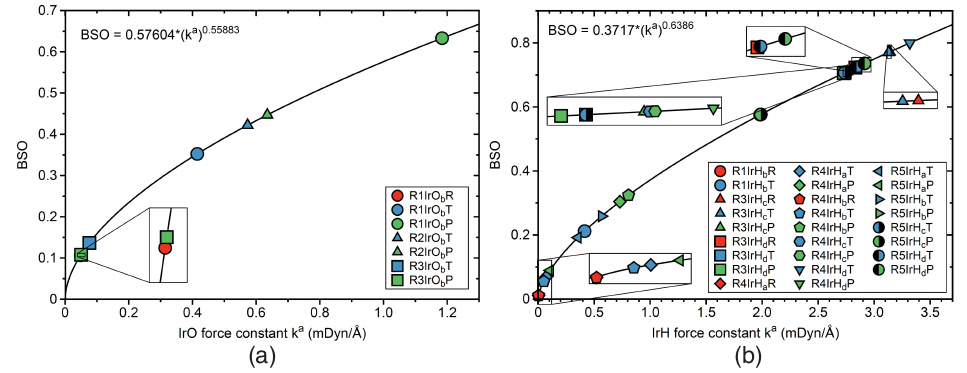
Figure 11. BSO values as a function of the local mode force constants k a , calculated from the power relationship BSO = A ∗ ( k a ) B ; for details, see text and Table 1. ( a ) IrO bonds; ( b ) IrH bonds. Labels R1IrO b R, R1IrO b T, and R1IrO b O indicate reactant RE (red color), TS (blue color), and product PR (green color) of the bond involving the Ir and O b atoms of thereaction R1 . Similarly notation for reactions R2 – R5 . For the bond label description see the text. B3LYP/6-31G(d,p)/SDD(Ir) level of